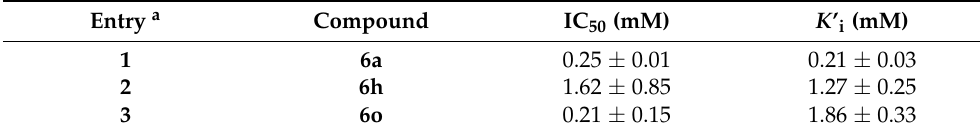
Table 3. Kinetic parameters for the F 1 F O -ATPase inhibition by Pzs. IC 50 and K ’ i values were graphically obtained from the Pzs’ titration curve and Cornish-Bowden plots of Figures 3 and 4,